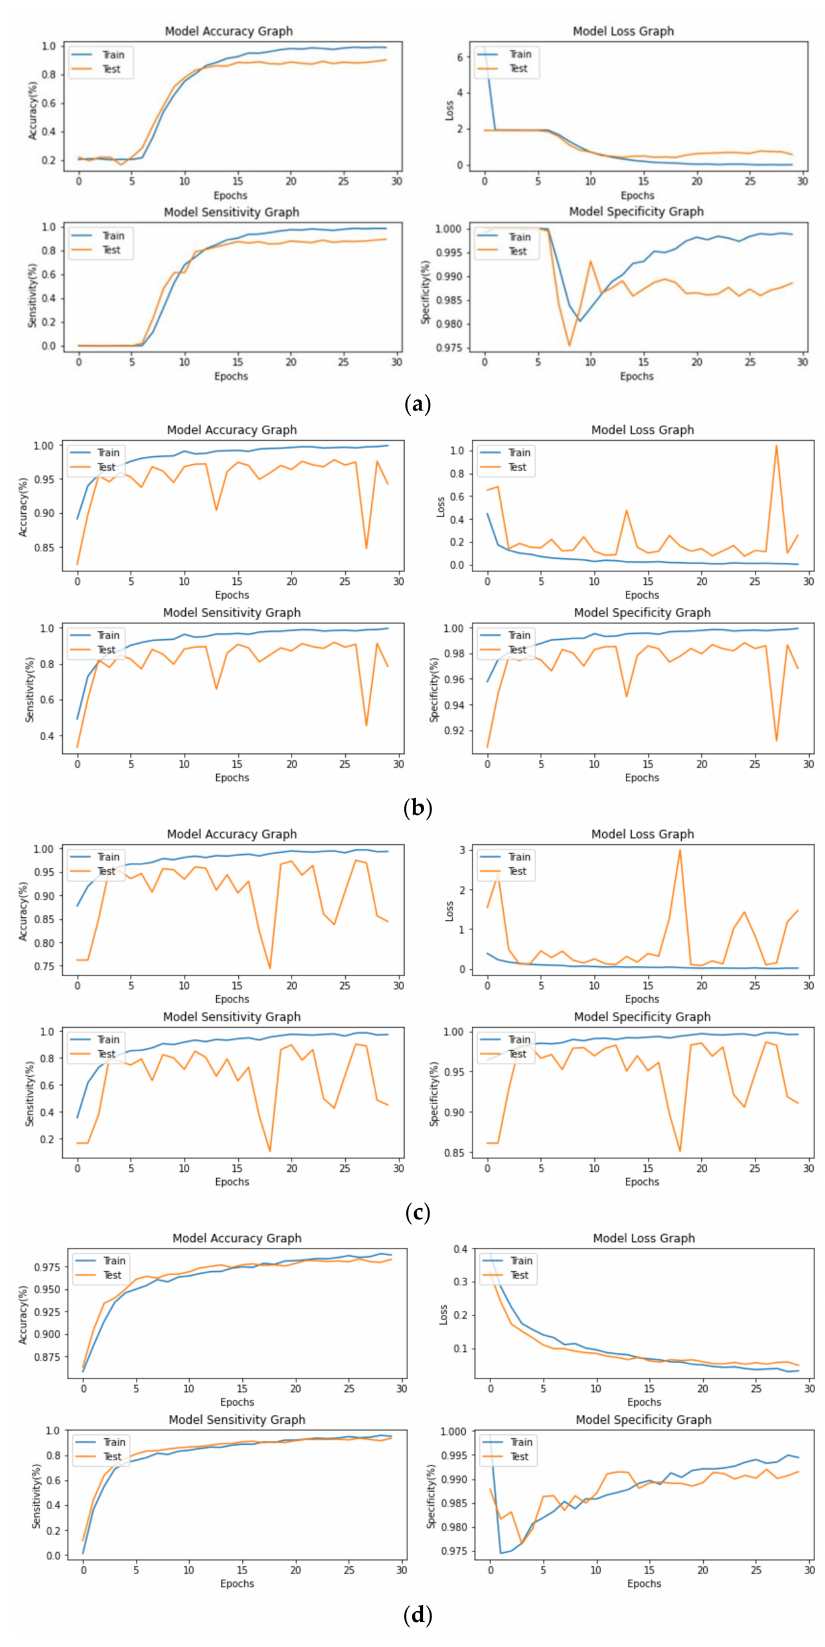
Figure 4. Graphs of changes throughout training: ( a ) the VGG-16 model; ( b ) ResNet-50 model; ( c ) ResNet-101 model; ( d ) proposed